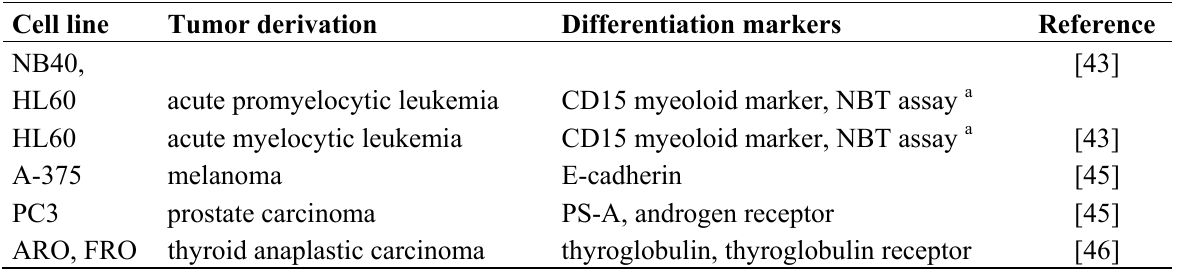
Table 1. Differentiation of human tumorigenic cell lines by reverse transcriptase (RT)